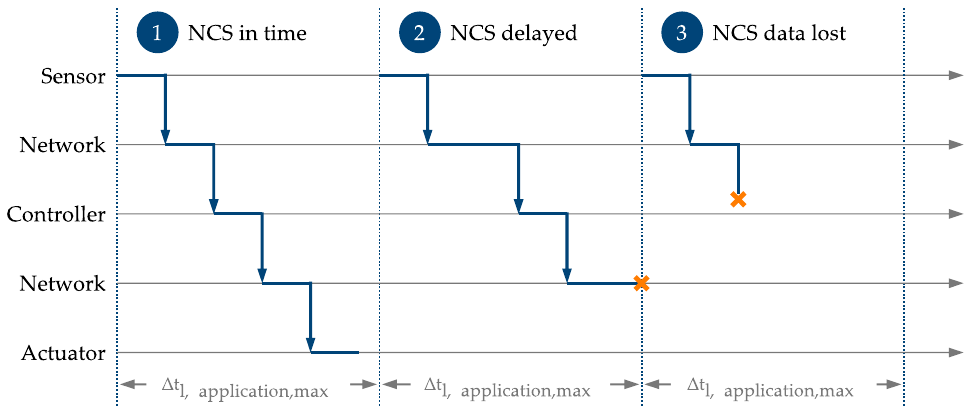
Figure 3. Timing diagram of a networked control system.